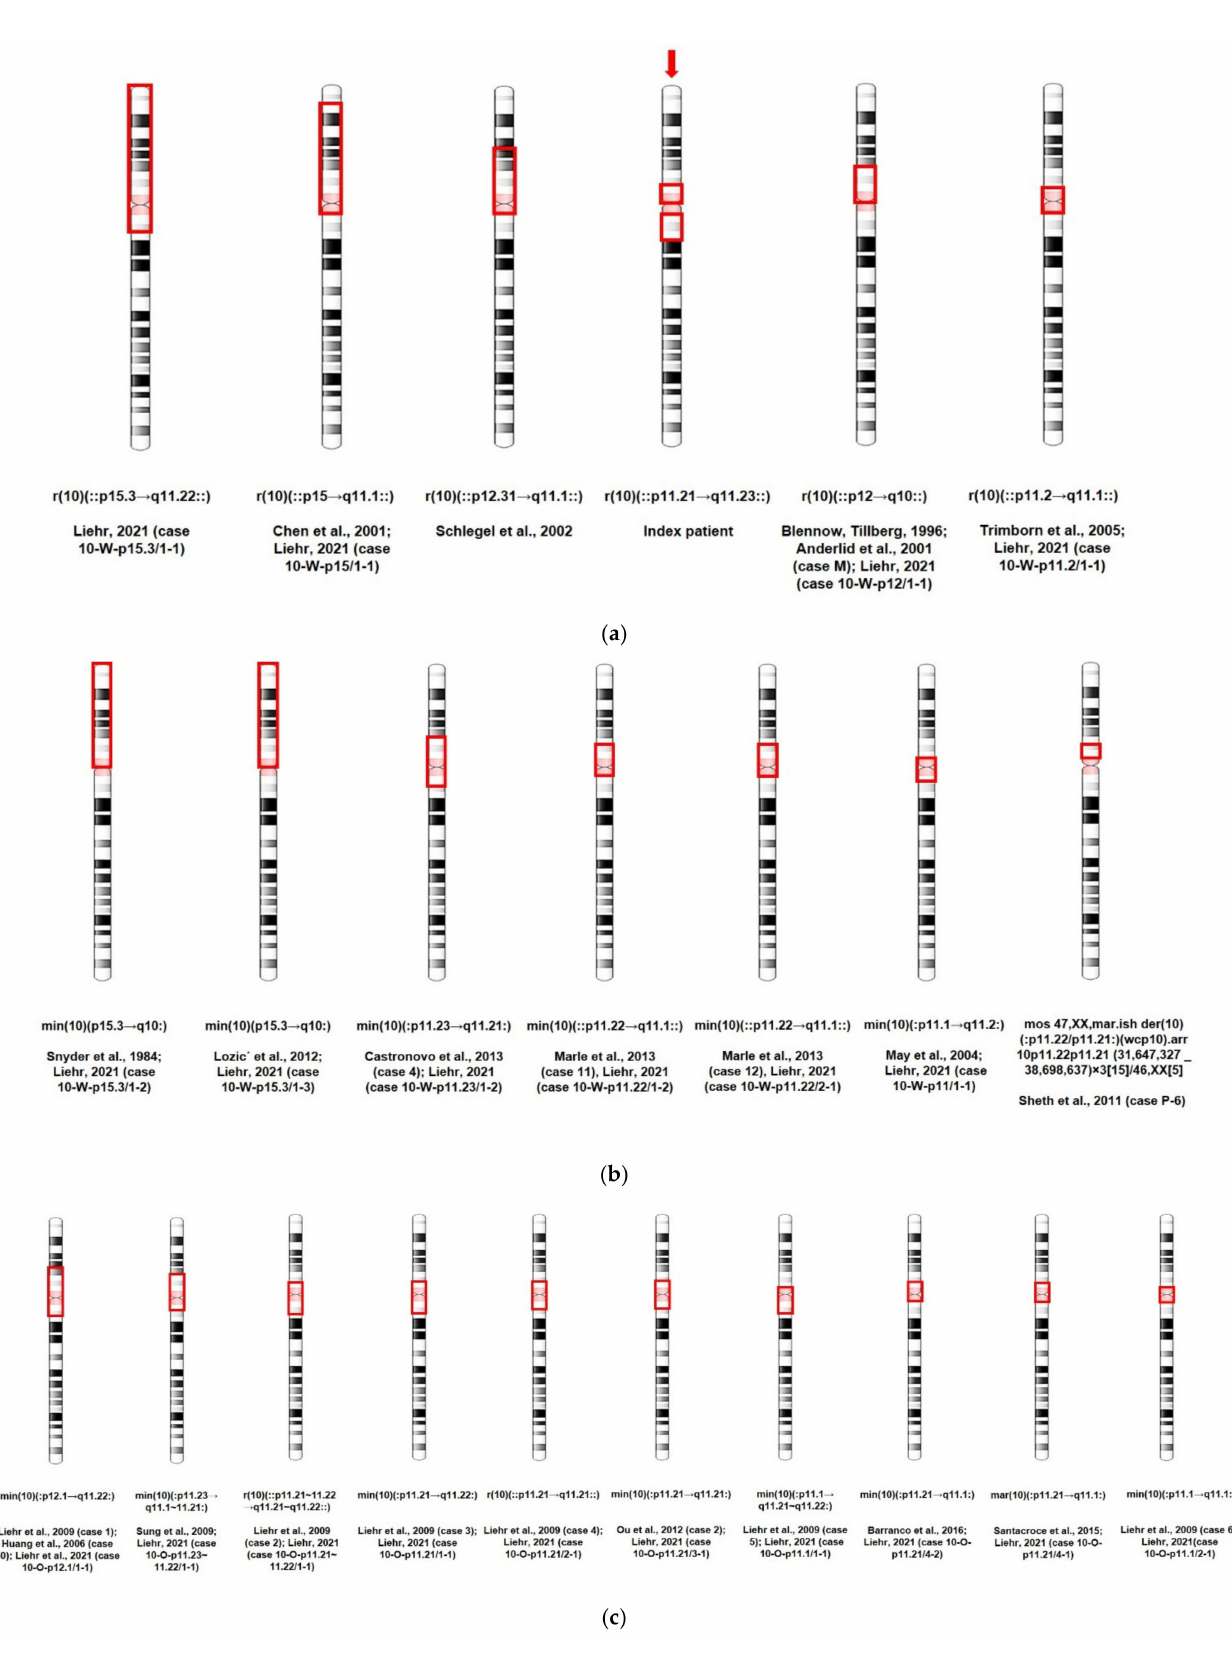
Figure 13. The size and origin of sSMC(10)s. The affected regions outlined by the red rectangle on chromosome 10 in the index patient are marked by red arrows. ( a ) Patients with supernumerary ring chromosome 10; ( b ) clinically affected carriers of an sSMC(10); ( c ) healthy carriers of an sSMC(10). The references are given in the Supplementary